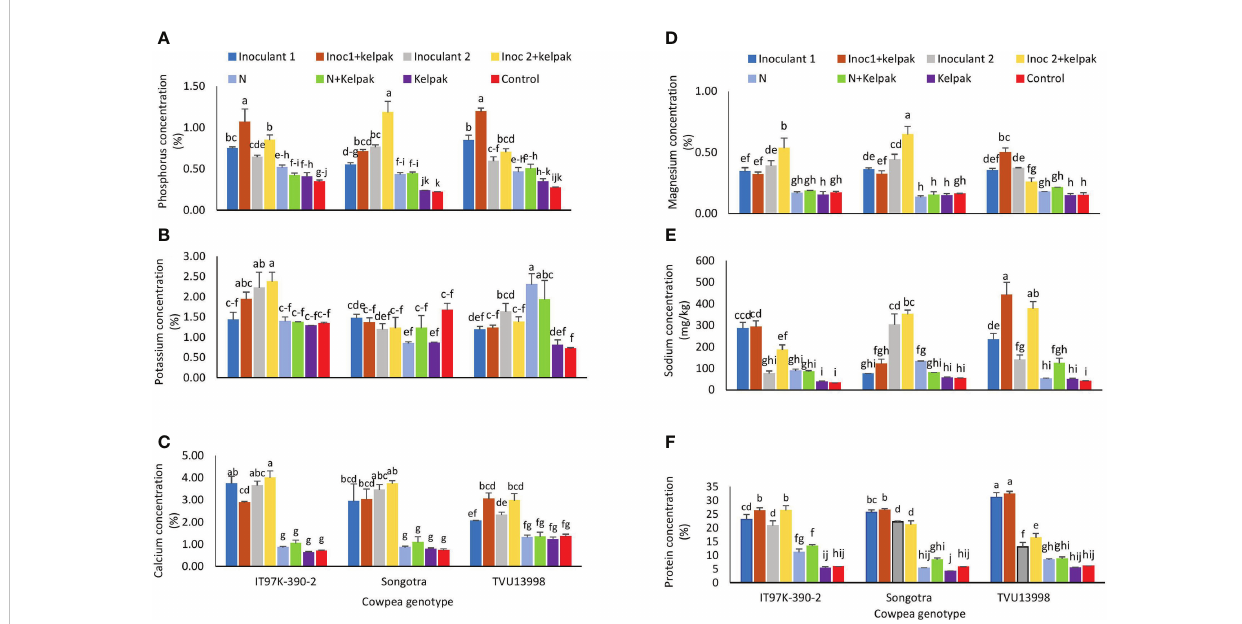
FIGURE 4 Interactive effect of genotype x treatment on the concentrations of Phosphorus (A) , Potassium (B) , Calcium (C) , Magnesium (D) , Sodium (E) , and protein (F) in the leaves of three cowpea genotypes, planted under glasshouse conditions. Inoculant 1(Inoc 1) = B . yuanmingense strain CB756 (commercial inoculant), Inoculant 2 (Inoc 2) = Bradyrhizobium sp. strain TUTVUSA (closely related to B . daqingense ), control = no inoculant and no kelpak, N= 5mM KNO 3, control= no inoculation and no kelpak. vertical lines on bars represent S.E. Bars followed by dissimilar letters are signi fi cant at ***p ≤